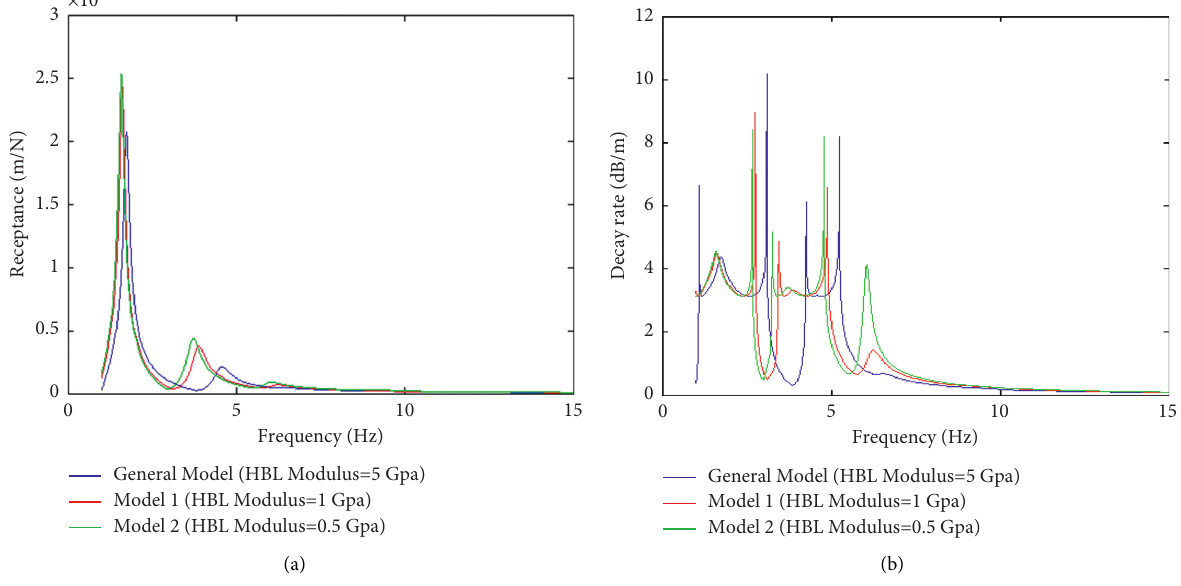
Figure 7: Effect of modulus changes on receptance and the decay rate of HBL: (a) effect of thickness on receptance and (b) effect of thickness on the decay rate.